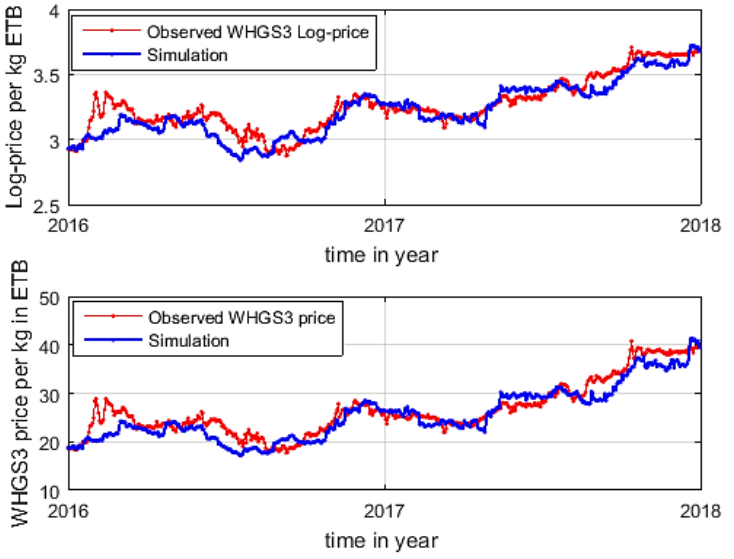
Figure 5. Simulated price fitted to WHGS3 log-price (Upper panel) and WHGS3 price (Lower panel) under Merton’s model from 2016 to